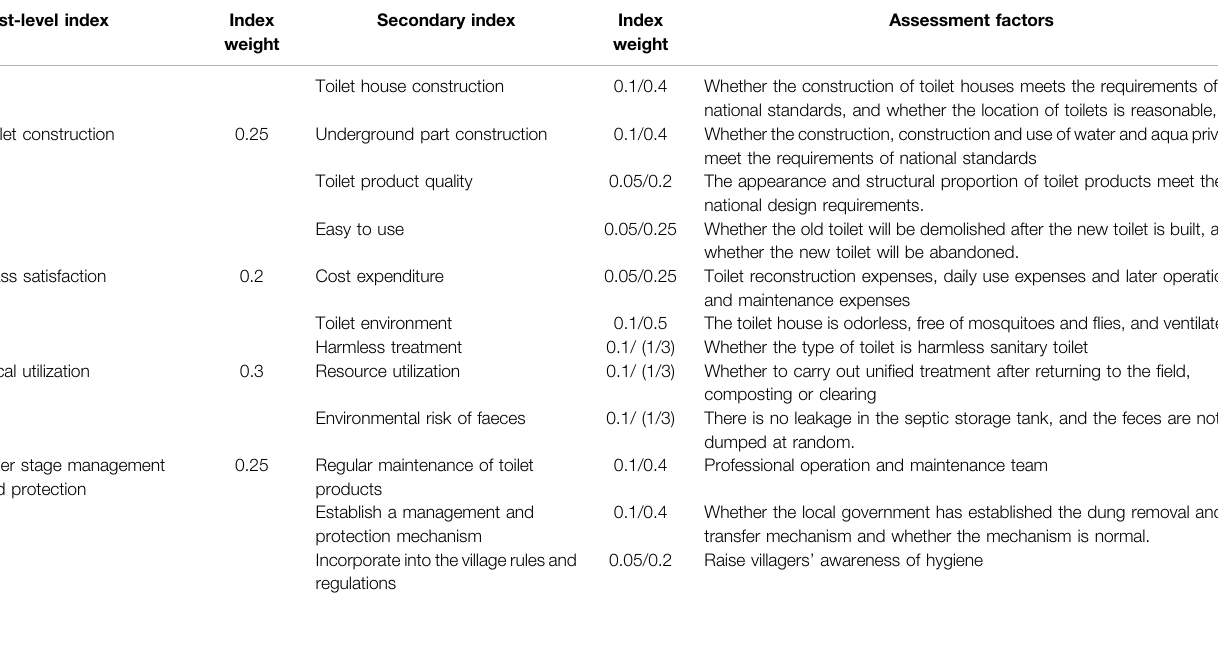
TABLE 2 | Evaluation index system of toilet improvement in rural